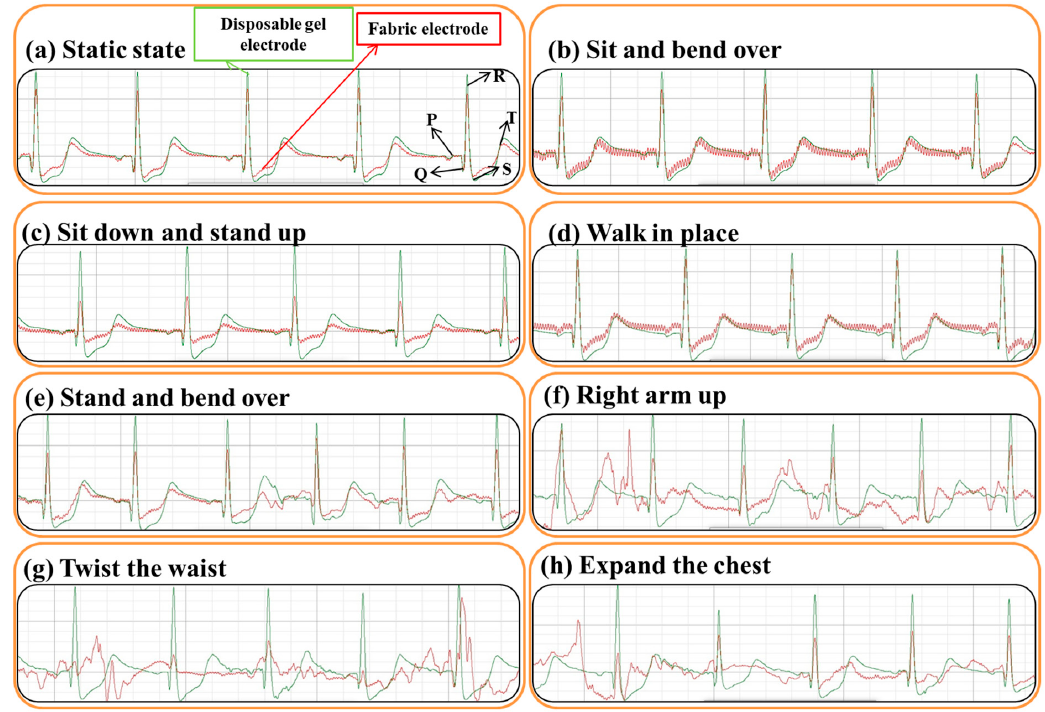
Figure 8. Cotton fabric electrodes and disposable gel electrodes monitor ECG in different states of the human body.